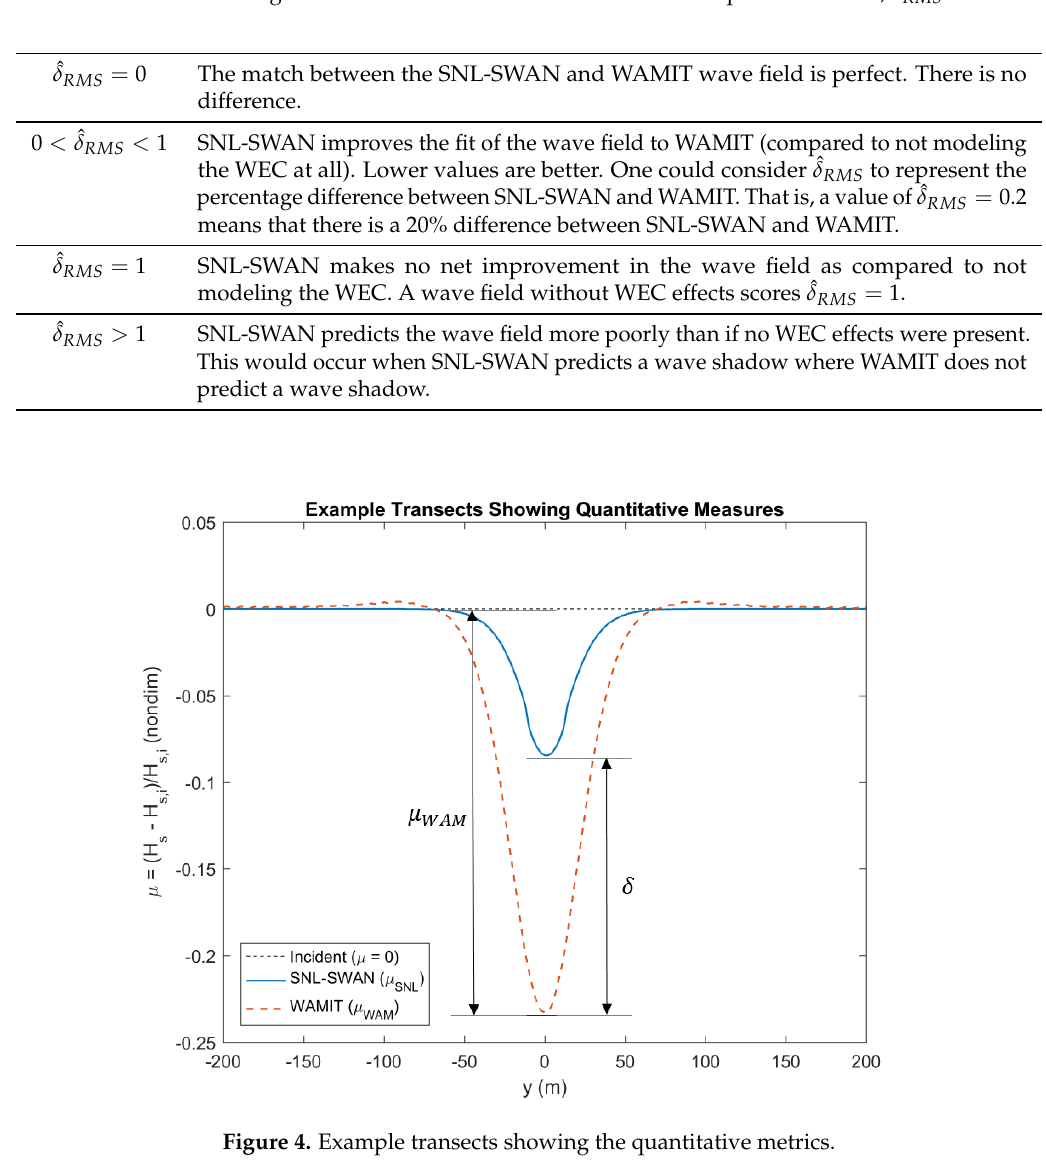
Table 4. Meaning of the values of the normalized root-mean-square difference, ˆ δ RMS .